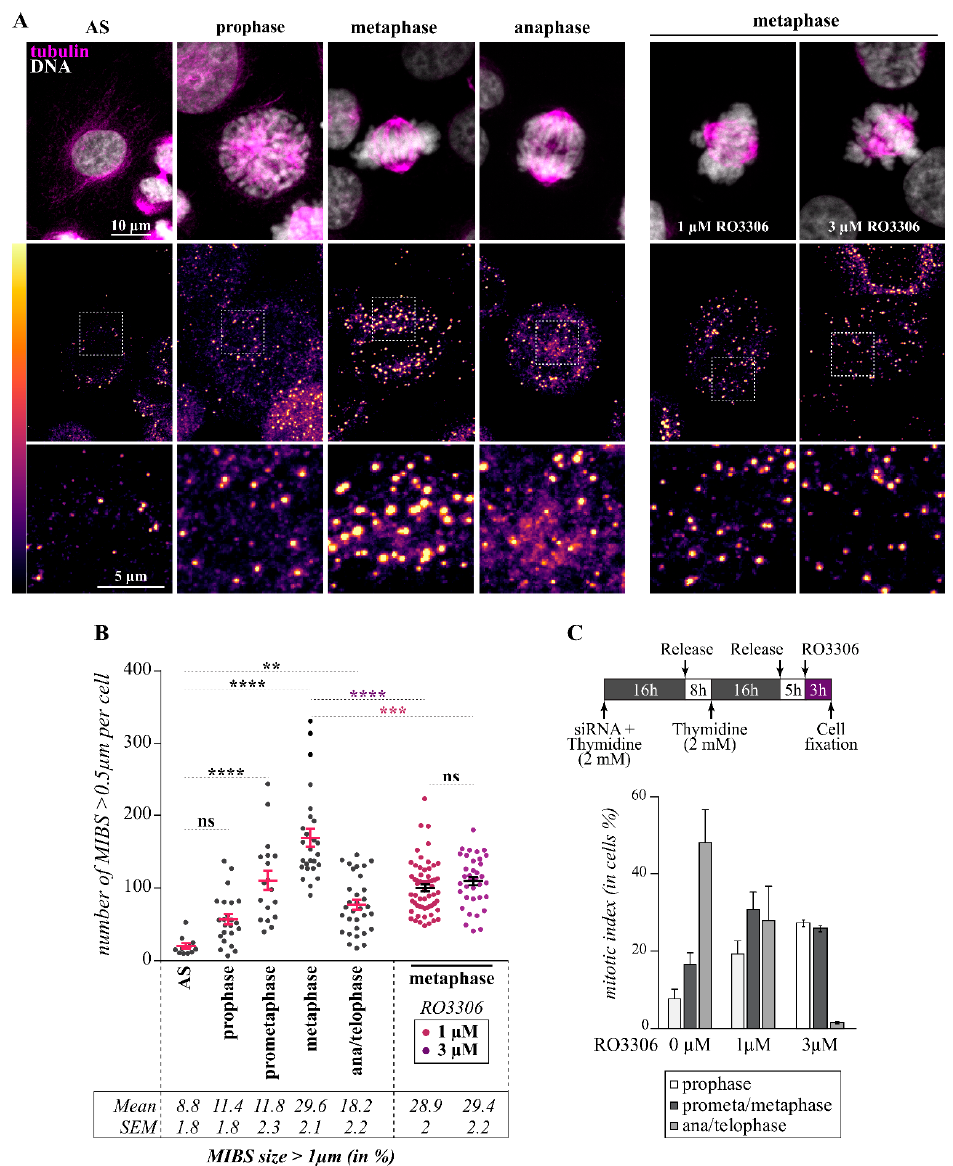
Figure 6. MIBS assembly is regulated by CDK1 activity. ( A ) Maximum intensity projections of confocal image stacks from representative HeLa-RFP-H2B cells synchronized in mitosis by a double thymidine block, showing staining of p62, β -tubulin, and DNA (Hoechst); cells were treated or not with low doses of the CDK1 inhibitor RO3306 for 3 h before cell fixation. Enlarged views of boxed regions are shown to emphasize MIBS assembly until metaphase and their disassembly at anaphase, and inhibition of MIBS assembly by the CDK1 inhibitor. A heatmap pseudo-color intensity scale was applied to the p62 staining channel to underscore MIBS assembly dynamics; Bars: 10 μ m or 5 μ m . ( B ) Quantification of cells from (A), indicating MIBS number per cell and their mean size during mitotic progression, means ± SE from 11 to 59 cells from 2 representative experiments. Statistical significance was analyzed with the Kruskal–Wallis test: ****, p < 0.0001; ***, p <